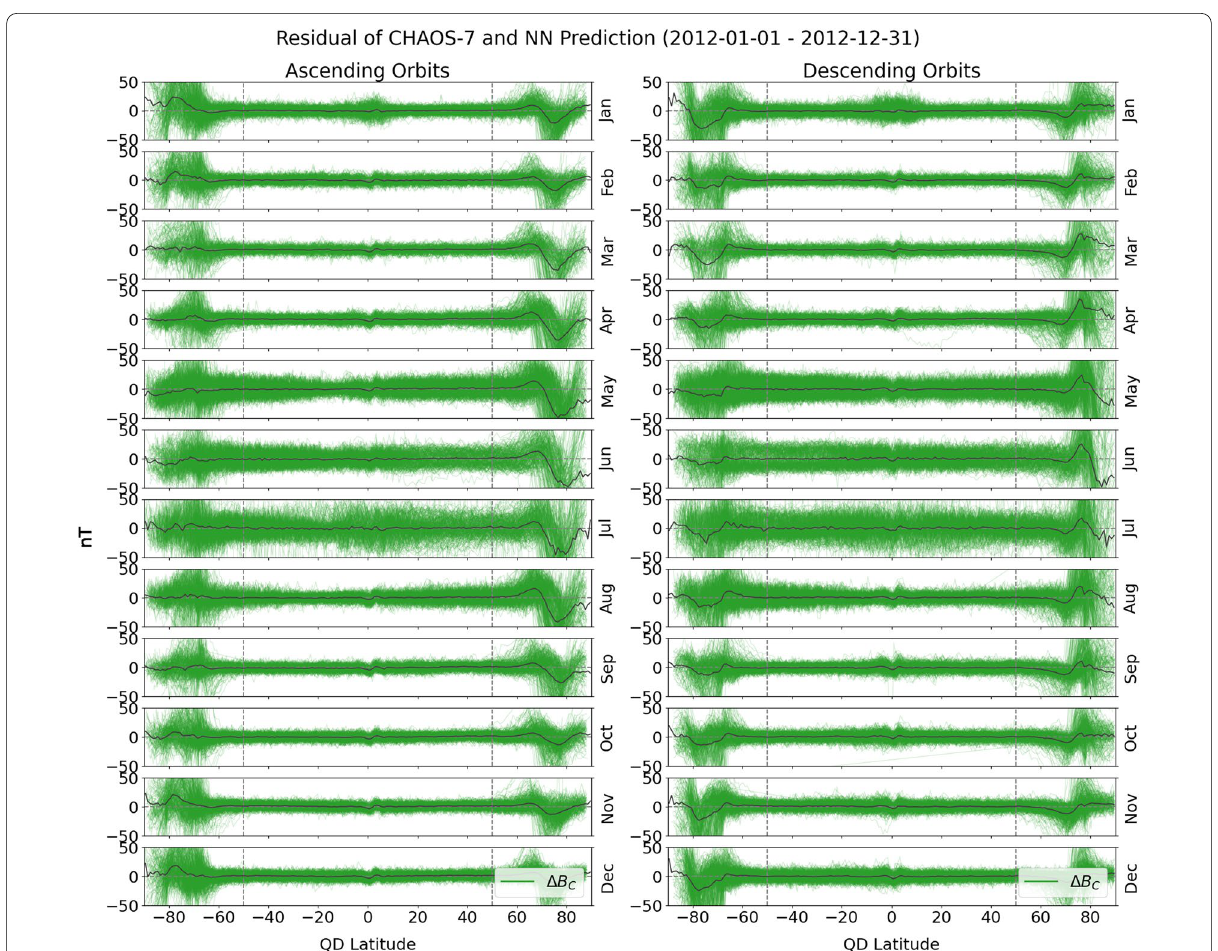
Fig. 6 Residual between the calibrated platform magnetometers and the CHAOS‑7 reference model as a function of the quasi‑dipole latitude (QDLAT) for every month of the year 2012 of the Center component of the calibrated measurement in nT. The orbits are split into the ascending dusk‑orbits on the left, and the descending dawn‑orbits on the right, with the mean residual depicted in